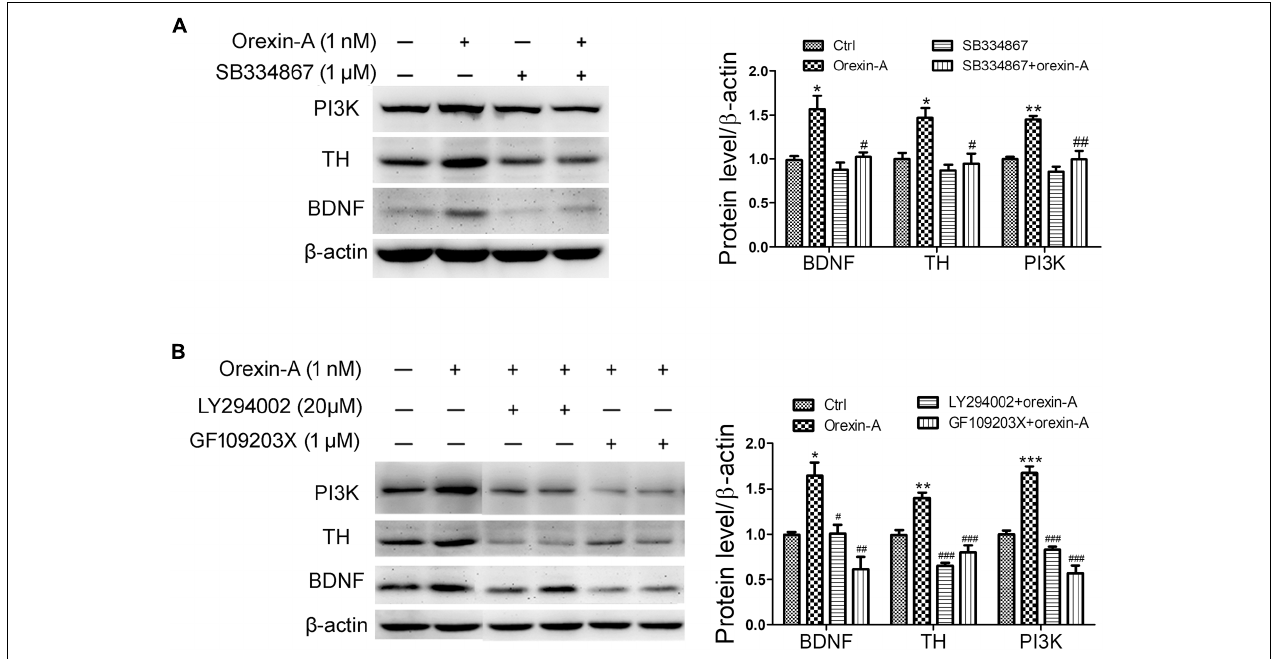
FIGURE 8 | Effects of signaling pathway inhibitors on the expression of BDNF induced by orexin-A in SH-SY5Y cells. (A) Effects of OX1R antagonist (SB334867) on the protein levels of PI3K, TH, and BDNF induced by orexin-A. ∗ P < 0.05, ∗∗ P < 0.01 vs. control; # P < 0.05, ## P < 0.01 vs. orexin-A. (B) Effects of PI3K inhibitor (LY294002) and PKC inhibitor (GF109203X) on the upregulation of TH and BDNF induced by orexin-A. Average protein level was quantified as ratios between BDNF/TH/PI3K and β -actin. Data were presented as mean ± SEM of three independent experiments. ∗ P < 0.05, ∗∗ P < 0.01, ∗∗∗ P < 0.001 vs. control; # P < 0.05, ## P < 0.01, ### P < 0.001 vs. orexin-A. Original images of the blots are shown in Supplementary Figures S6 – S10